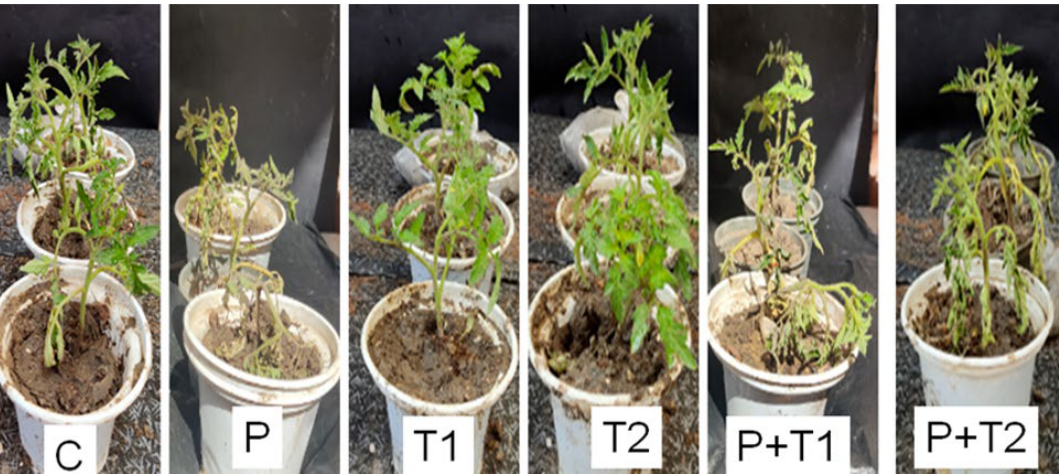
Figure 4. Effects of highest concentrations of M. spicata and M. longifolia EOs formulations on L. esculentum seedling growth potential under Fusarium root rot disease infection. C = control, P = pathogen, T1 = 1.25% M. spicata , T2 = 1% M. longifolia , P + T1 = pathogen + 1.25% M. spicata , and P + T2 = pathogen + 1% M. longifolia . 2.4. Protein, Total Phenols, Flavonoids, Malondialdehyde Contents, and Antioxidant